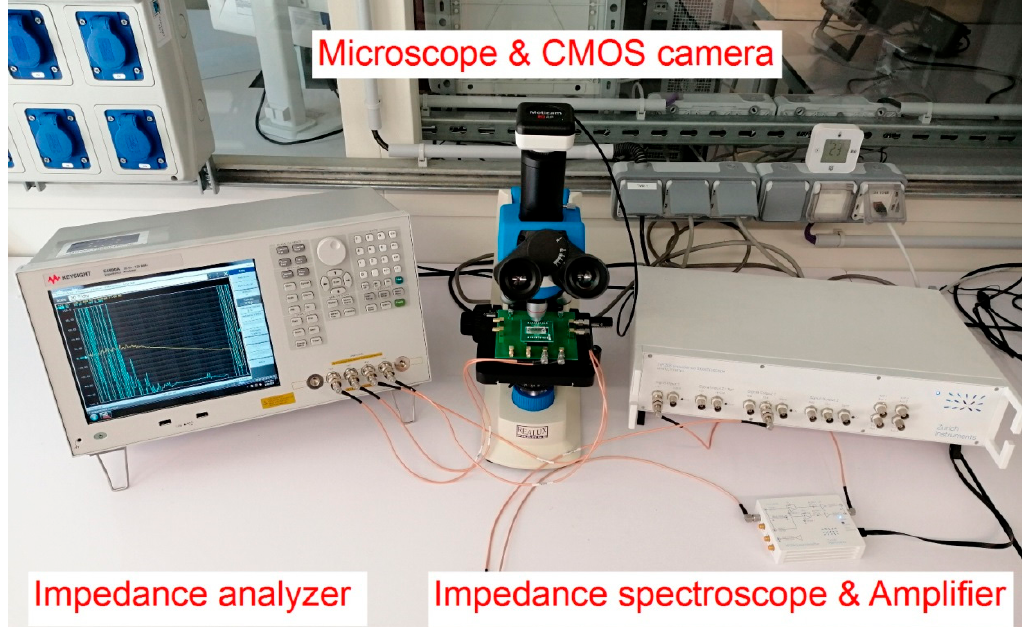
Figure A4. Photographs of the measurement setup with impedance analyzers, impedance spectroscope with amplifiers, and optical microscope with sensors.